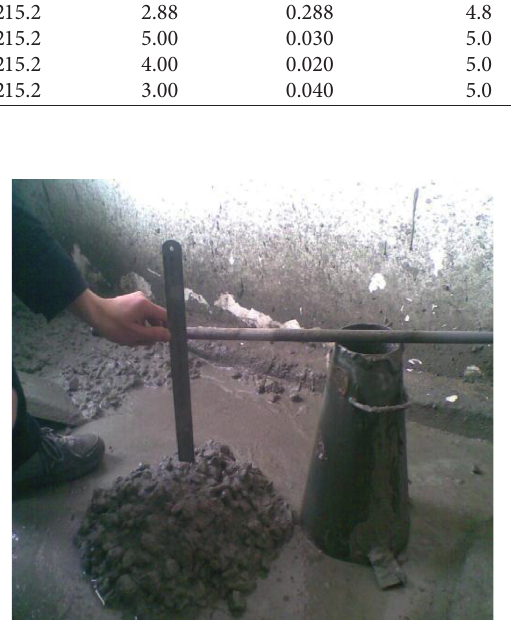
Figure 1: The slump